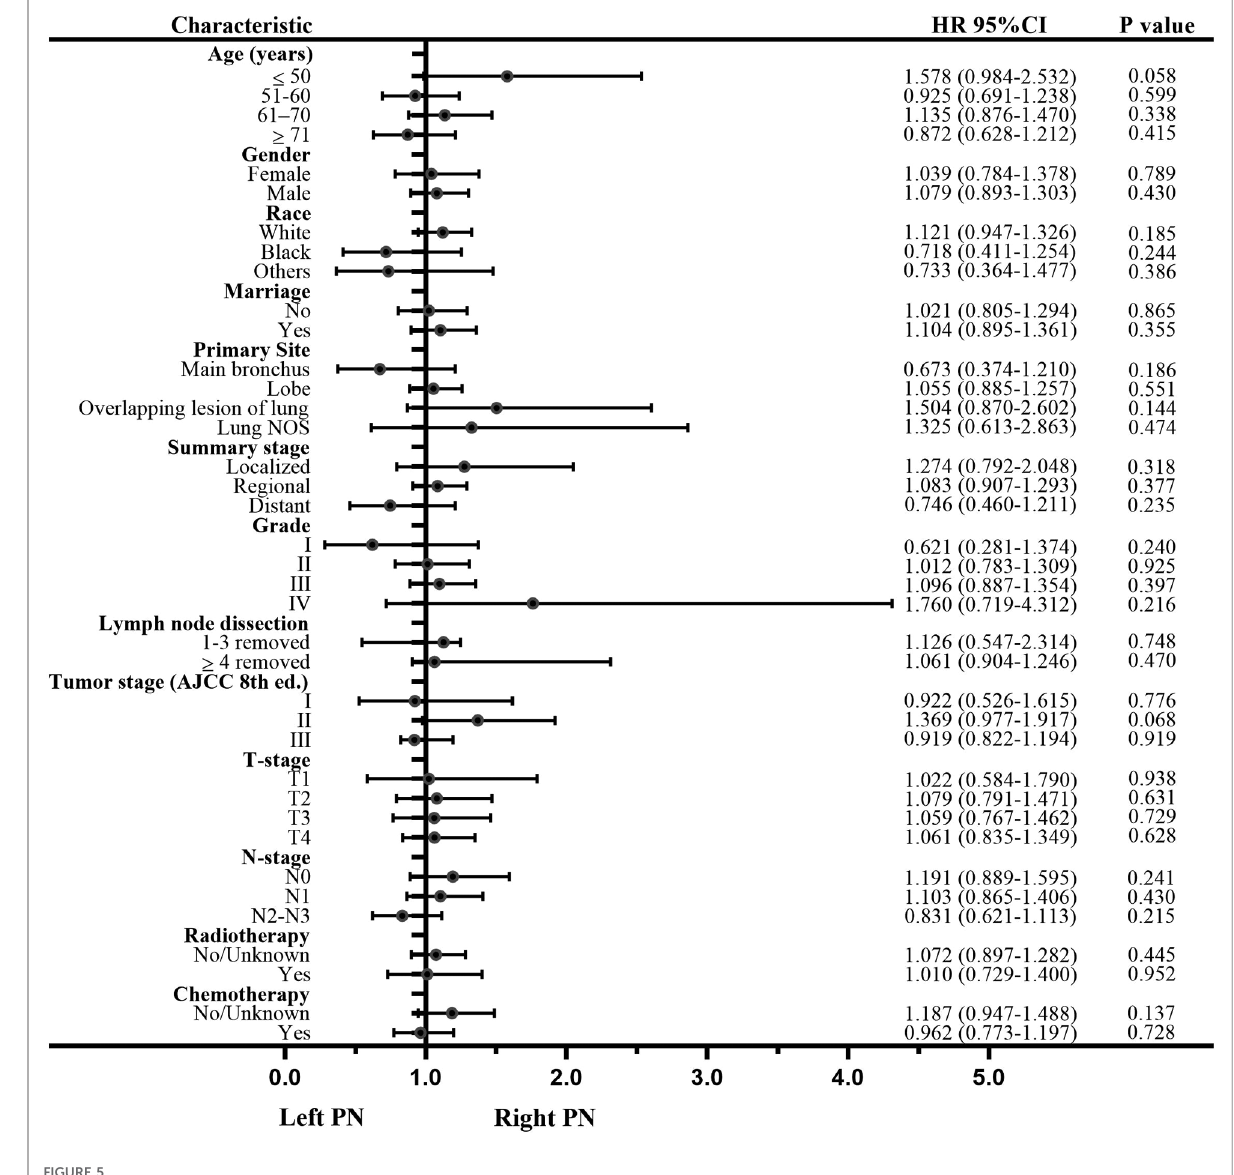
FIGURE 5 Forest plot of individual hazard ratios for the overall survival in left vs. right